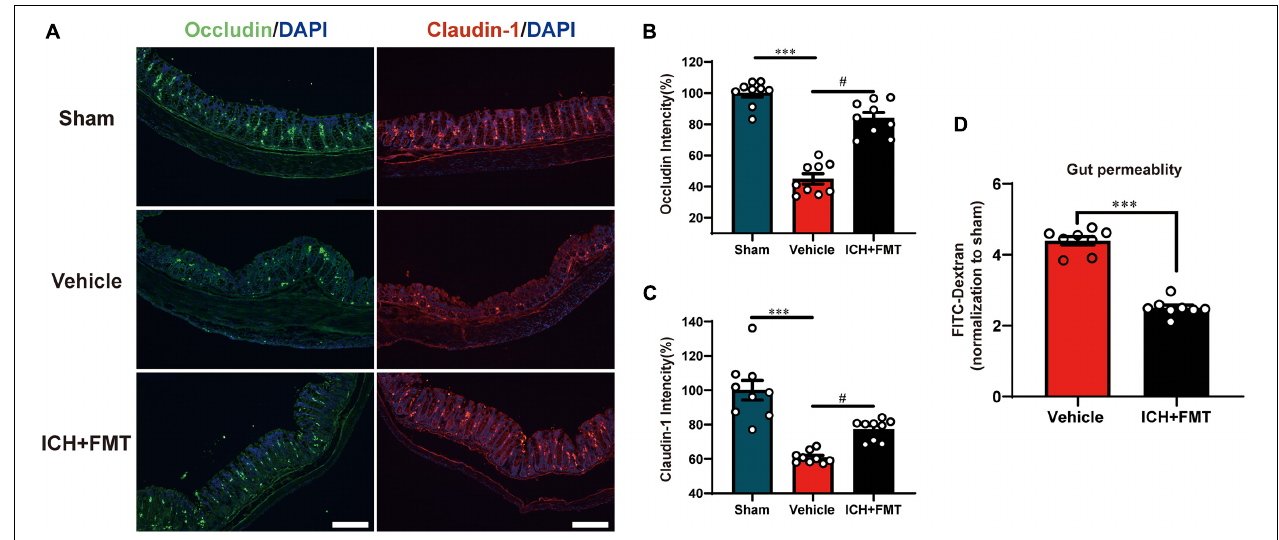
FIGURE 8 | Transplantation of healthy fecal microbiome improves gut intestinal integrity after ICH. (A) Representative immunofluorescence staining of the tight junction proteins Occludin and Claudin-1 in sham, vehicle, and ICH + FMT mice colons. (B,C) Mean of densities of Occludin and Claudin-1 ( n = 3 per group, 3 individual experiments). (D) Intestinal permeability was improved after FMT treatment for 7 days ( n = 4 per groups, two individual experiments). Data are expressed as the mean ± SEM. ∗∗∗ P < 0.001 vs . sham group. # P < 0.05 vs . vehicle group. Scale bar = 200 µ